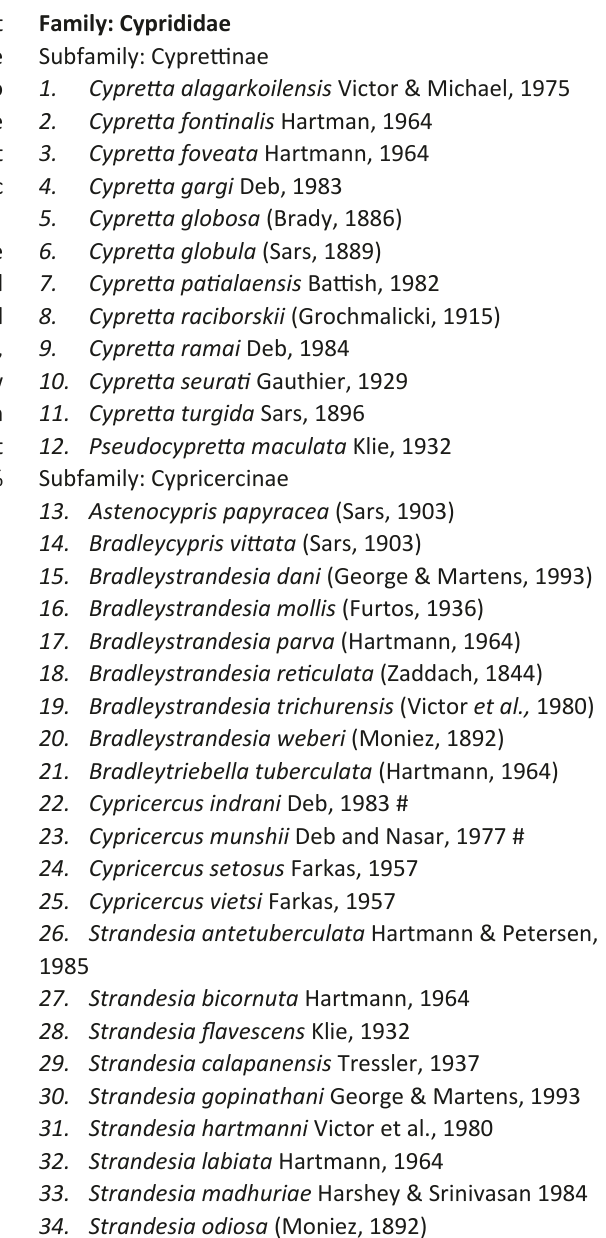
(World and Oriental region data source from Martens et al. 2008)